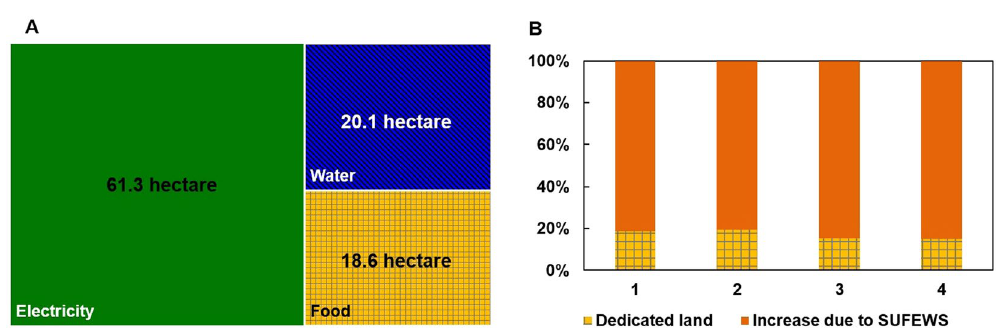
Figure 5. ( A ) Land area requirement to produce same electricity and water output of case 1 from separate dedicated lands. Note that when this is done, food production drops to only 18.6 hectare from the full 100 hectare of production achieved with SUFEWS. ( B ) Food production relative to a 100 hectare SUFEWS land for four different cases considered